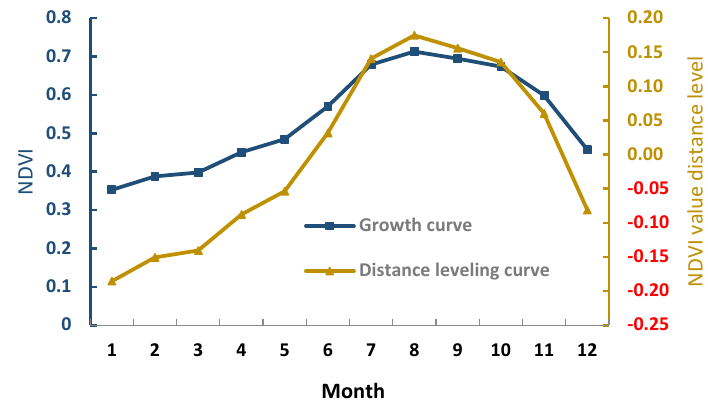
Figure 18. Grassland growth process curve and NDVI distance level in 2021.